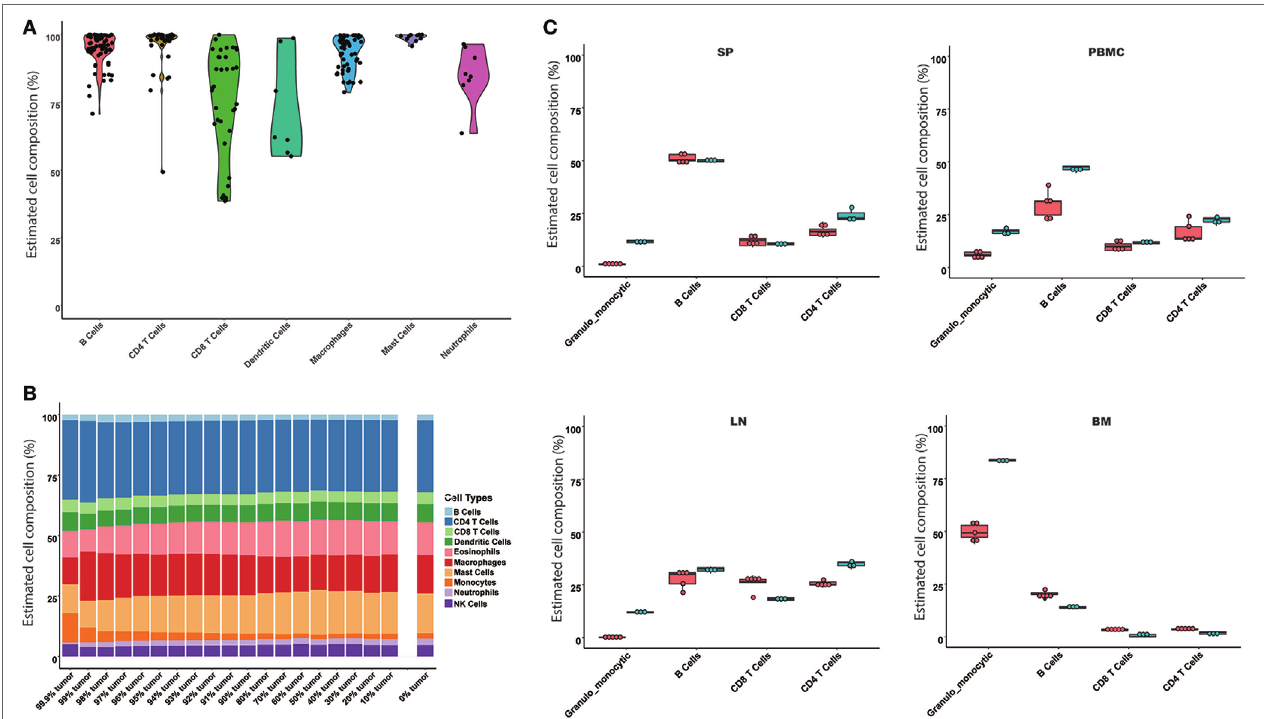
FIGURe 2 | Evaluation of the seq-ImmuCC model in the simulated and experimental data. The performance of the model was evaluated in the enriched cell samples (A) , simulated tumor samples (B) , and measured results from flow cytometry (C) . Four immune cell types were compared in (C) , namely, granulo- monocytic cells, CD4 T cells, CD8 T cells, and B cells. Red: predicted results; green: flow cytometry